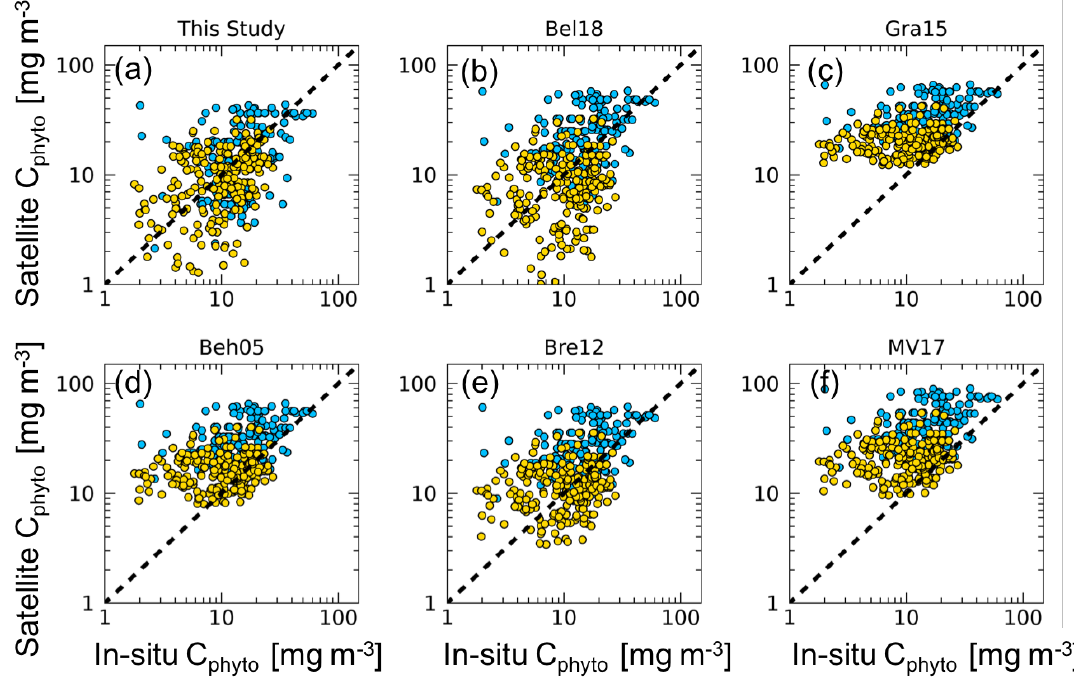
Figure 2. Matchups between satellite C phyto versus in situ C phyto data for each algorithm (N = 396). The dashed line represents the 1:1 ratio. Gold dots represent in situ C phyto data corresponding to OWCs 1–6; blue dots represent in situ C phyto data for OWCs 7–13. Statistics are reported in Table 1.